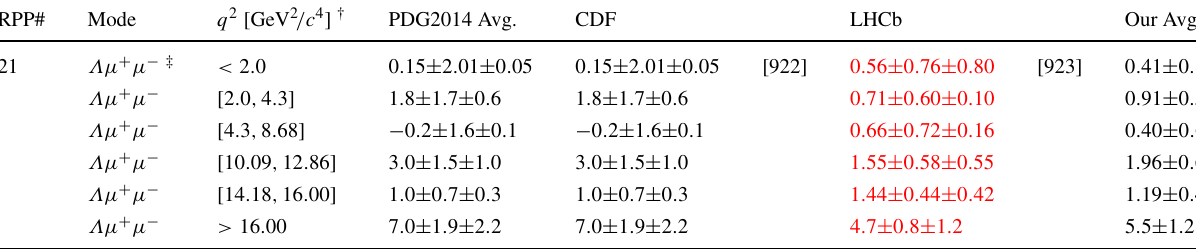
→ μ + μ − decays in intervals of q 2 = m 2 (μ + μ − ) in units of × 10 − 6 . Where values are shown in Table230 Partial branching fractions of Λ 0 b red (blue), this indicates that they are new published (preliminary) results since PDG2014